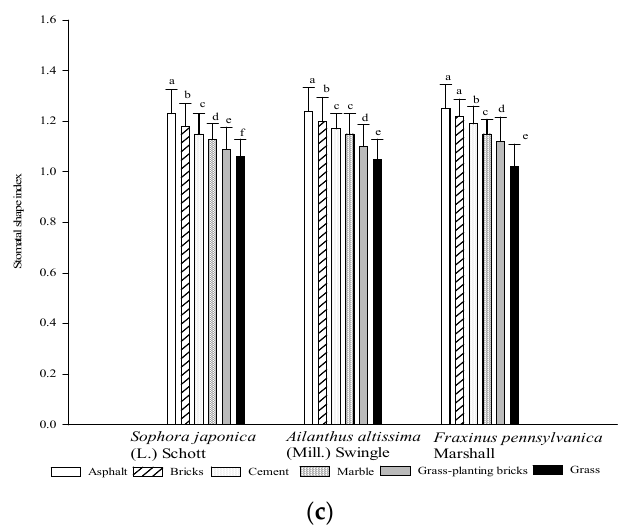
Figure 3. Stomatal characteristics under six urban underlying surface environments. ( a – c ) Refers to stomatal density, stomatal area and stomatal shape index under different underlying surface types.